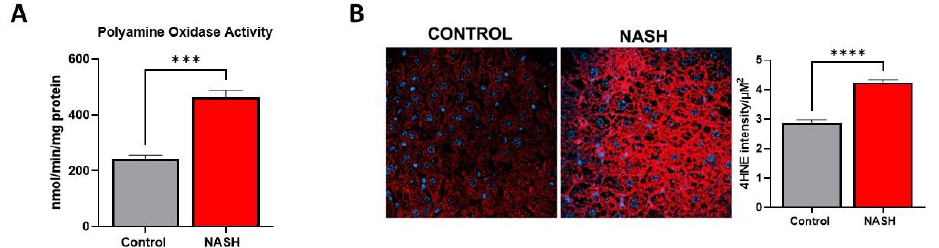
Figure 7. Increased activity of polyamine oxidase and oxidative damage in NASH. ( A ) Activity of polyamine oxidase in control and NASH livers. ( B ) Immunofluorescence staining of control and NASH livers for 4-hydroxynonenal modified proteins. Quantification of the fluorescence is shown on the right. Data presented as mean ± SEM (N = 4, **** p < 0.0001, *** p < 0.001).